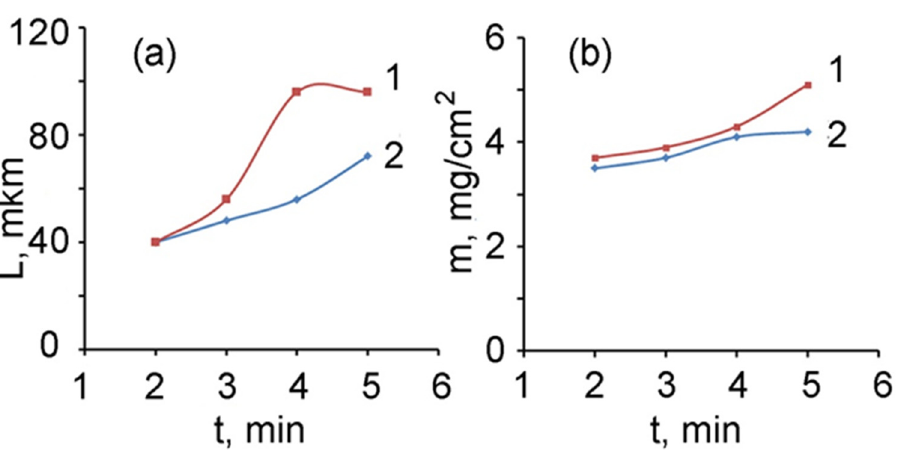
Figure 12. Thickness of layer 3 ( a ) and specific gravity of the PMAA/AuNPs composite ( b ) versus electrolysis time. 1–electrolyte 4, 2–electrolyte 3.